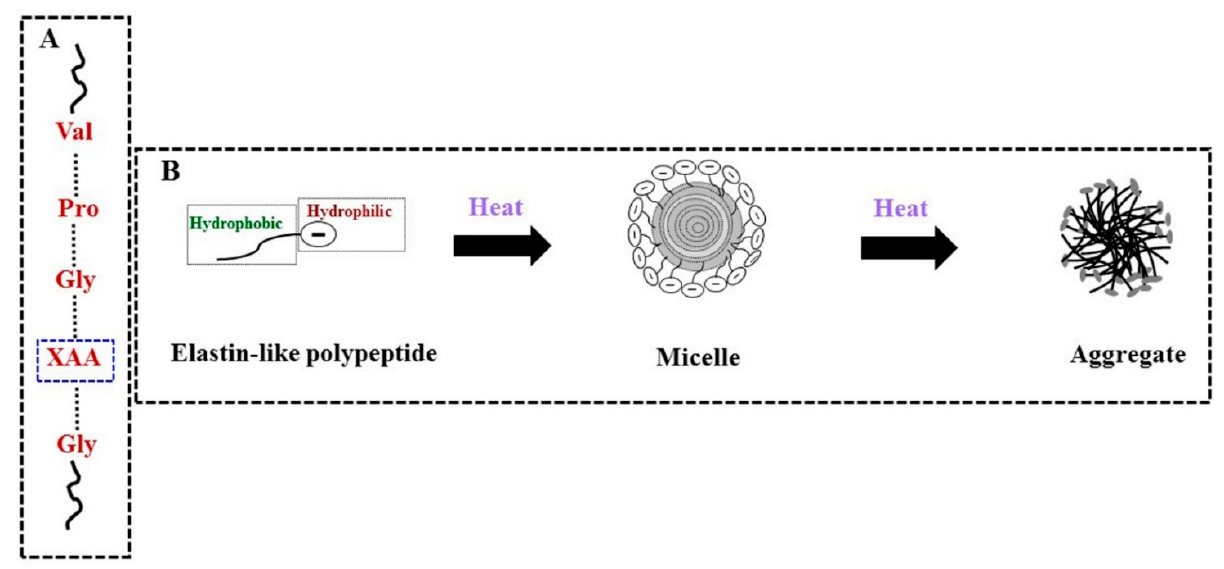
Figure 6. ( A ) The consensus the repeat sequence of elastin-like polypeptide (XAA: any amino acid except proline); and ( B ) Sol–gel transformation of elastin-like polypeptide with an increase in temperature. The single molecule of the elastin-like polypeptide is made of hydrophilic and hydrophobic blocks and starts to form aggregates upon heating through micellar intermediate formation. Above inverse transition temperature of both hydrophobic and hydrophilic blocks, elastin-like polypeptides start to form aggregates. In addition, upon cooling below their inverse transition temperature, the aggregate changes to single molecules in the solution.